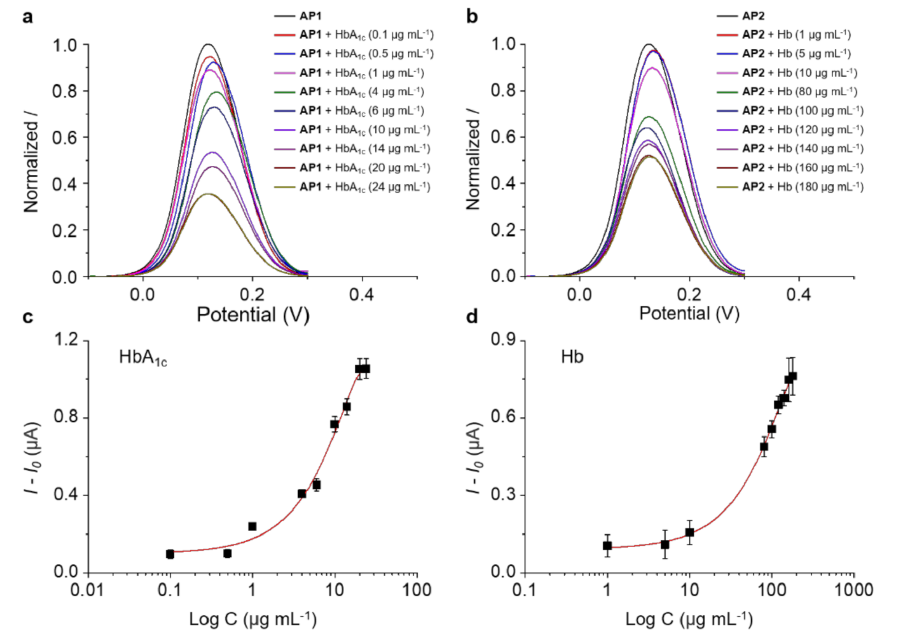
Figure 3. Differential pulse voltametric curves of ( a ) aptasensor 1 ( AP1 ) with increasing HbA 1c and ( b ) aptasensor 2 ( AP2 ). The current intensity ( I ) of an aptasensor in the absence of HbA1c or Hb is normalized to that of the aptasensor in the presence of HbA1c or Hb. ( c ) Plotting the current changes of aptasensor 1 ( AP1 ) with increasing HbA 1c , and ( d ) Plotting the current changes of aptasensor 2 ( AP2 ) with increasing Hb, where I and I 0 are the current intensity of an aptasensor in the presence and absence of protein analyte, respectively. Error bars mean standard deviation (n = 3).